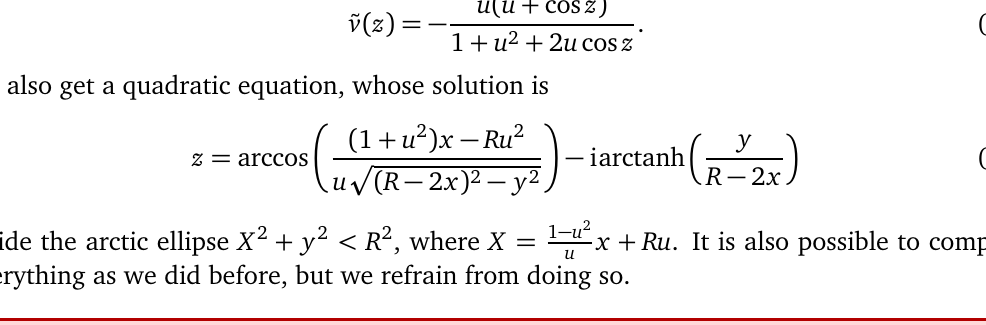
Figure 16: Minimisers for dimers on the honeycomb